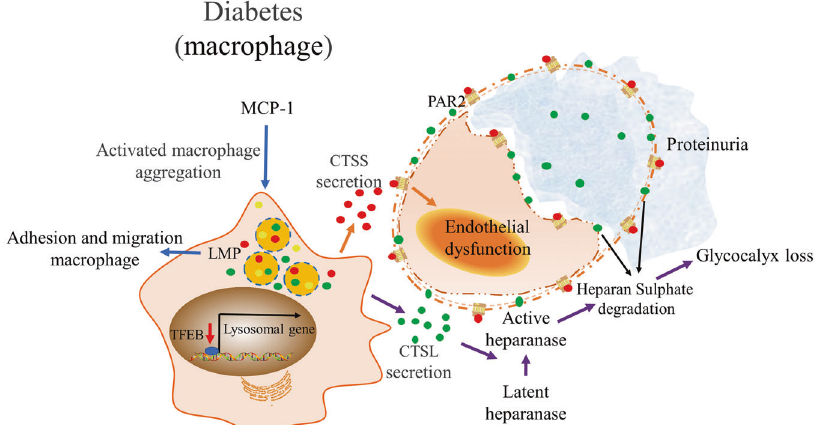
Fig. 4 Mechanism of lysosomal dyshomeostasis in macrophages and its effect on renal endothelial cells during DKD. Lysosomal dysfunction promotes adhesion and migration of macrophages 125 . Decreased TFEB activity in macrophages is involved in kidney injury 126 . MCP-1 promotes activated macrophage glomerular aggregation 133,134 . Macrophage-derived CTSS could induce diabetic renal endothelial cell damage by activating PAR2 on the surface of endothelial cells 132 . CTSL can be secreted into the extracellular space of the kidney by glomerular macrophage in fi ltration, resulting in renal heparanase activation and subsequent glycocalyx loss and proteinuria 137,138 . CTSL, cathepsin L; CTSS; cathepsin S; DKD, diabetic kidney disease; MCP-1, monocyte chemotactic protein-1; PAR2, protease-activated receptor-2; TFEB, transcription factor